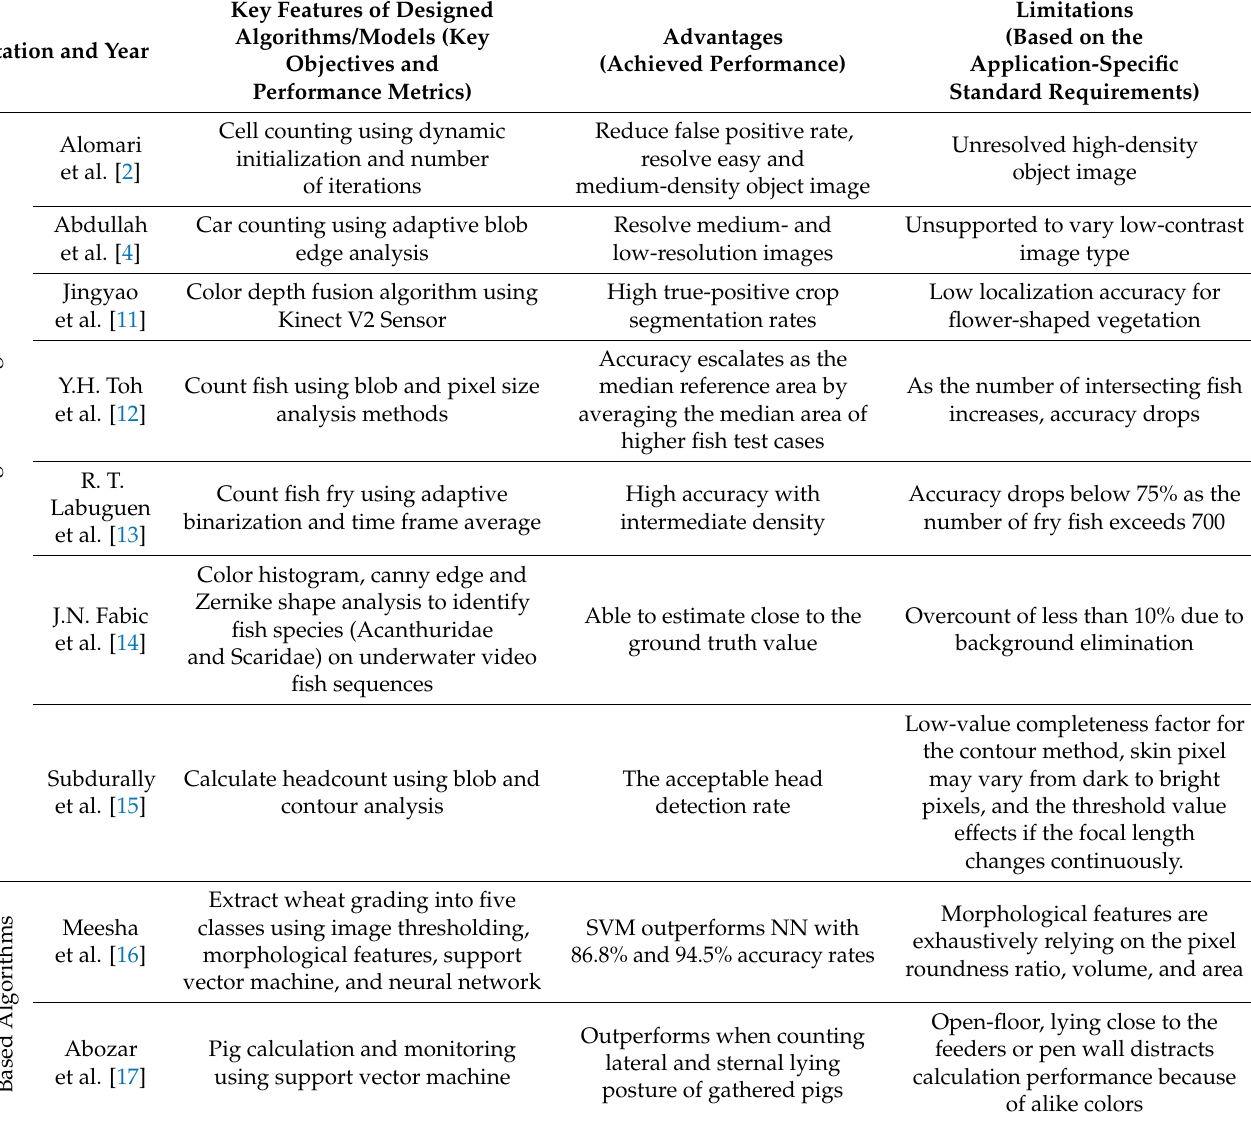
Table 1. Summary of the comparative analysis for the counting object-related